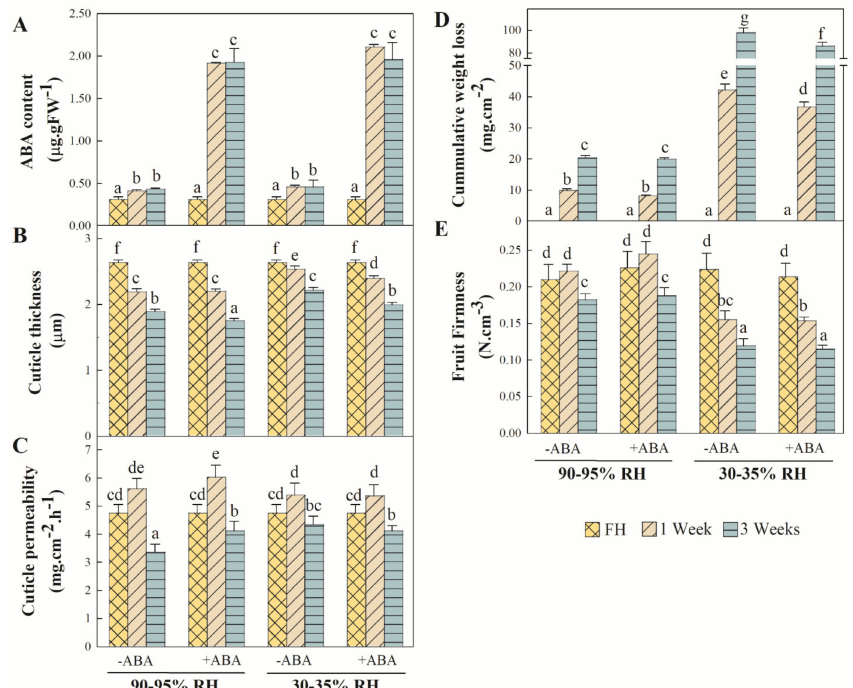
Figure 4. Effect of ABA and water stress on cuticle properties and fruit physiological parameters in Pinalate fruit. ( A ) ABA content is expressed as g per g of fresh weight (FW) of the flavedo. Bars are the means ± SD of three replicates of five fruit each. ( B ) Cuticle thickness. Bars represent the means ± SD of about 50 measurements for all three biological replicates analyzed per condition. ( C ) Cuticle permeability. Bars are the means ± SD of three replicates per condition. ( D ) Cumulative weight loss of Pinalate fruit calculated as fruit weight loss per surface area. Bars are the means ± SD of three replicates of 10 fruit each. ( E ) Fruit firmness was determined according to the intact fruit compression resistance load (N) and normalized by fruit size (cm 3 ). Bars indicate the means ± SD of three replicates of 10 fruit each. For each studied parameter, different letters indicate the statistical ( p < 0.05) differences in all the conditions together according to an ANOVA analysis followed by a Tukey test ( p <